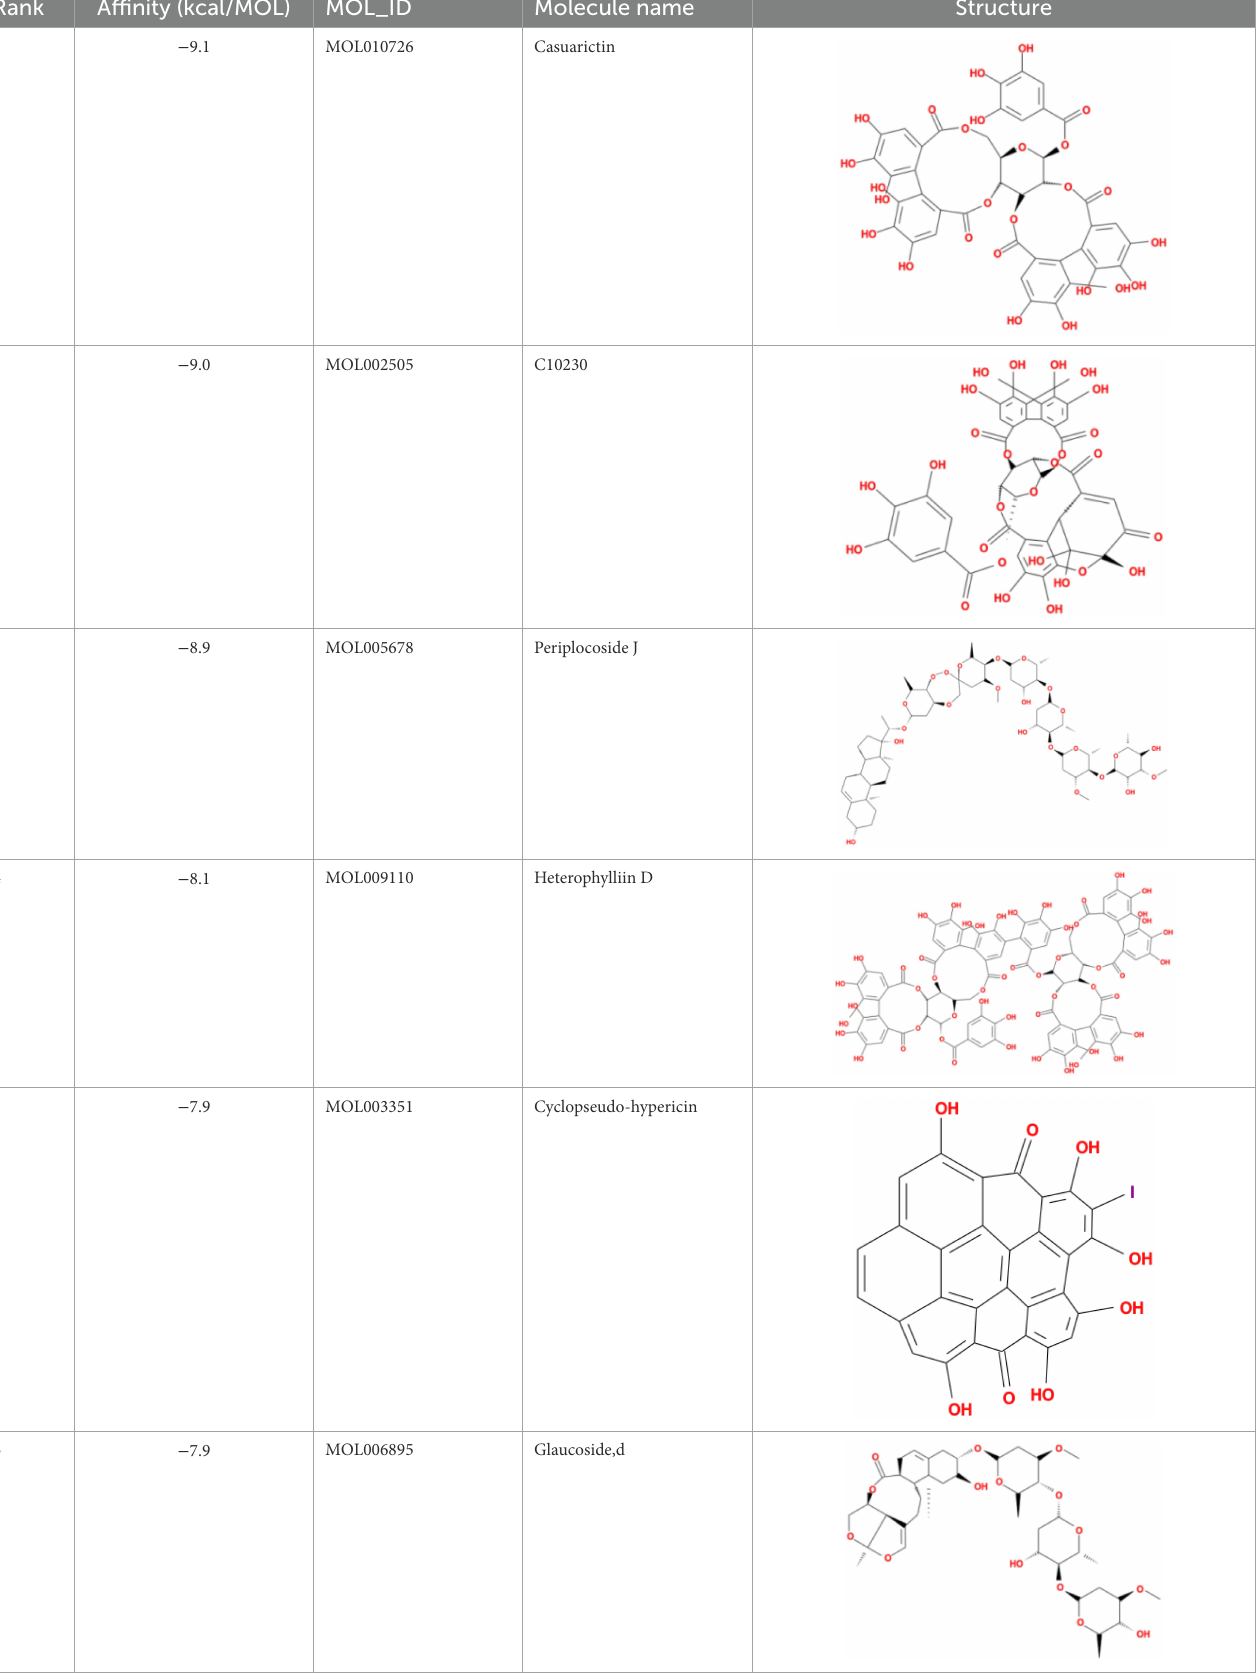
TABLE 3 Molecular docking results of Lambda S-CTD mutant bases and compounds.